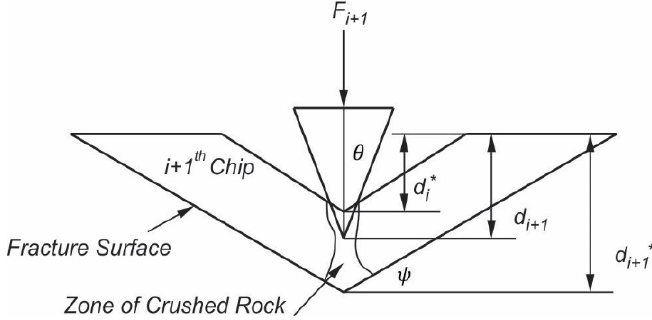
Figure 2. The model of penetration of one tooth into the rock [40 ].